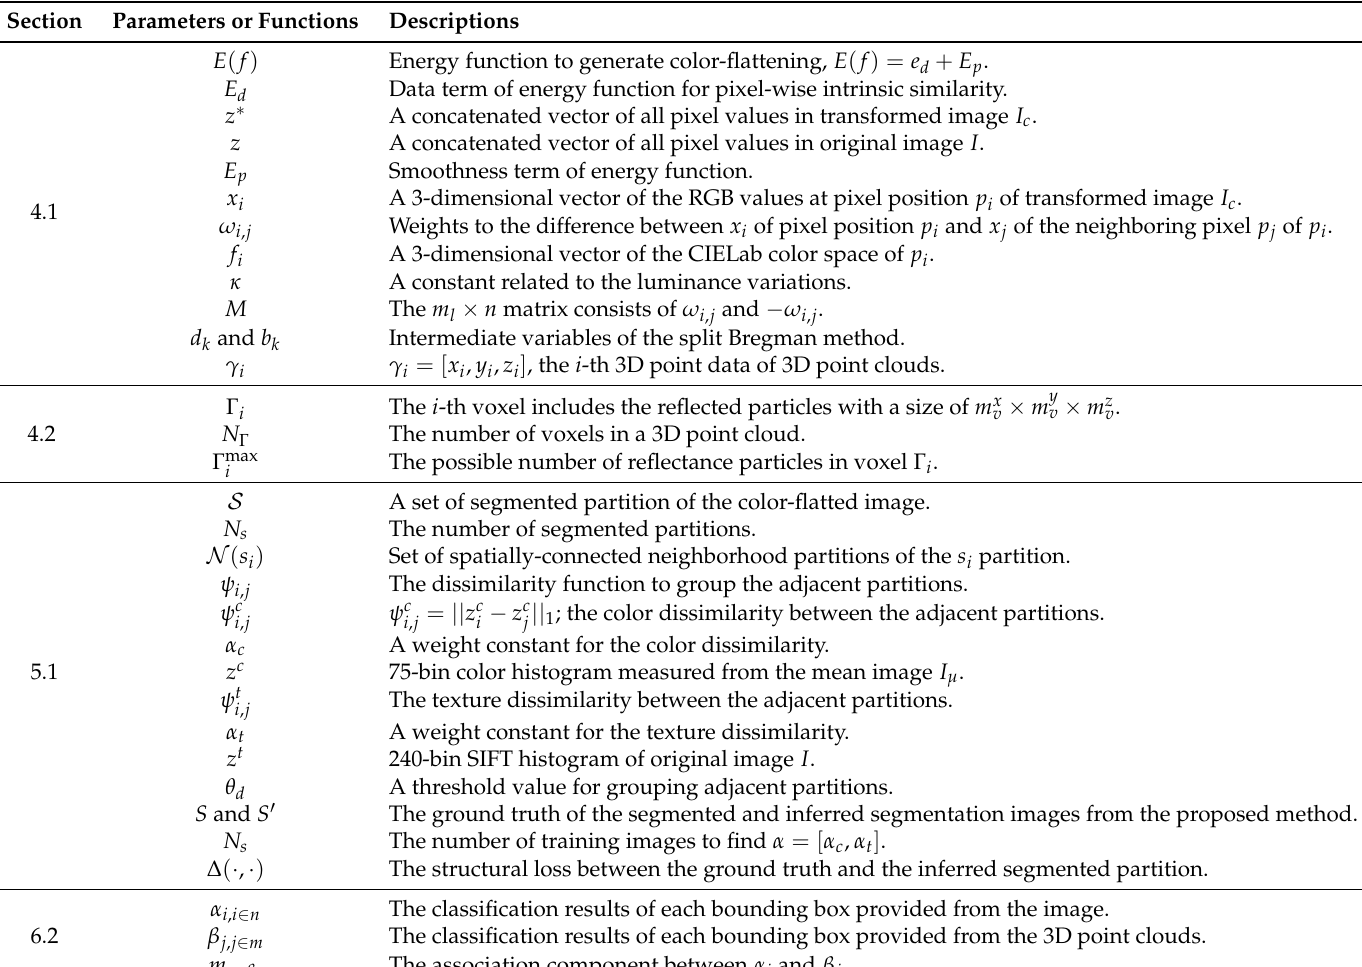
Table 1. The notation of the used parameters and